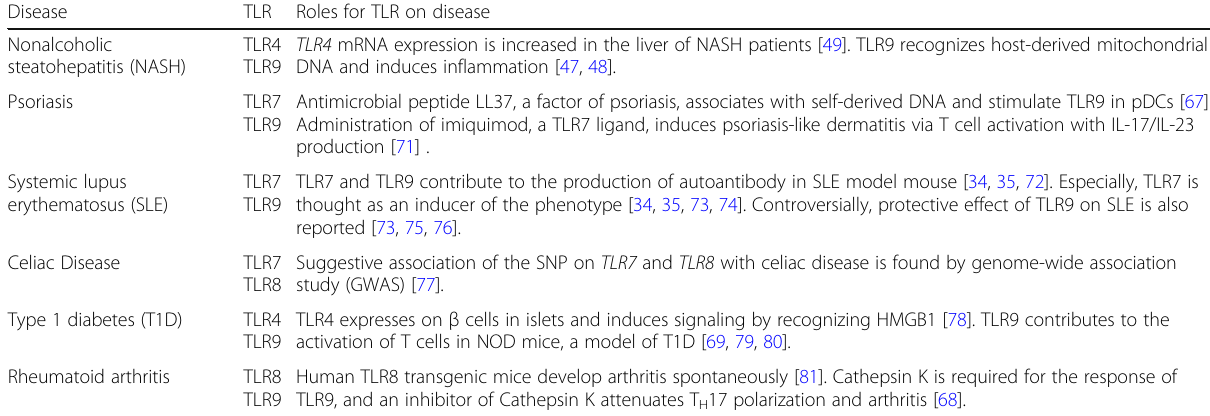
Table 1 Relation of TLRs with chronic inflammatory diseases Disease TLR Roles for TLR on disease TLR4 mRNA expression is increased in the liver of NASH patients [49]. TLR9 recognizes host-derived mitochondrial Nonalcoholic TLR4 steatohepatitis (NASH) TLR9 DNA and induces inflammation [47, 48]. Psoriasis TLR7 Antimicrobial peptide LL37, a factor of psoriasis, associates with self-derived DNA and stimulate TLR9 in pDCs [67]. TLR9 Administration of imiquimod, a TLR7 ligand, induces psoriasis-like dermatitis via T cell activation with IL-17/IL-23